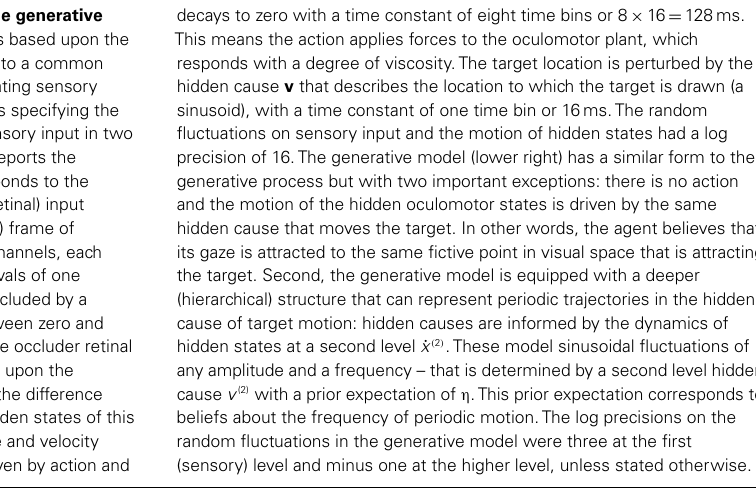
decays to zero with a time constant of eight time bins or 8 × 16 = 128ms. This means the action applies forces to the oculomotor plant, which responds with a degree of viscosity.The target location is perturbed by the hidden cause v that describes the location to which the target is drawn (a sinusoid), with a time constant of one time bin or 16ms.The random fluctuations on sensory input and the motion of hidden states had a log precision of 16.The generative model (lower right) has a similar form to the generative process but with two important exceptions: there is no action and the motion of the hidden oculomotor states is driven by the same hidden cause that moves the target. In other words, the agent believes that its gaze is attracted to the same fictive point in visual space that is attracting the target. Second, the generative model is equipped with a deeper (hierarchical) structure that can represent periodic trajectories in the hidden cause of target motion: hidden causes are informed by the dynamics of hidden states at a second level ˙ x ( 2 ) .These model sinusoidal fluctuations of any amplitude and a frequency – that is determined by a second level hidden cause v (2) with a prior expectation of η .This prior expectation corresponds to beliefs about the frequency of periodic motion.The log precisions on the random fluctuations in the generative model were three at the first (sensory) level and minus one at the higher level, unless stated